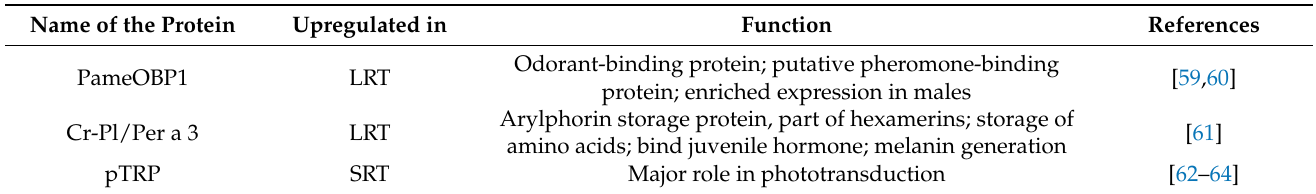
Table 1. Description of three DEGs identified and their putative